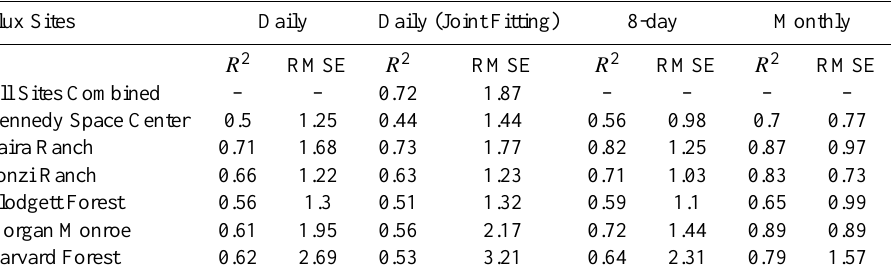
Table 3. Variance reduced ( R 2 ) and Root mean squared error (RMSE; MgC/day/km 2 ) of the best GR model data at the daily, 8-day and monthly scales. The column “Daily (Joint Fitting)” represents the statistics based on deriving a single daily GR model and set of regression coefficients using data from all sites combined, and the associated R 2 and RMSE of this model for the individual sites.